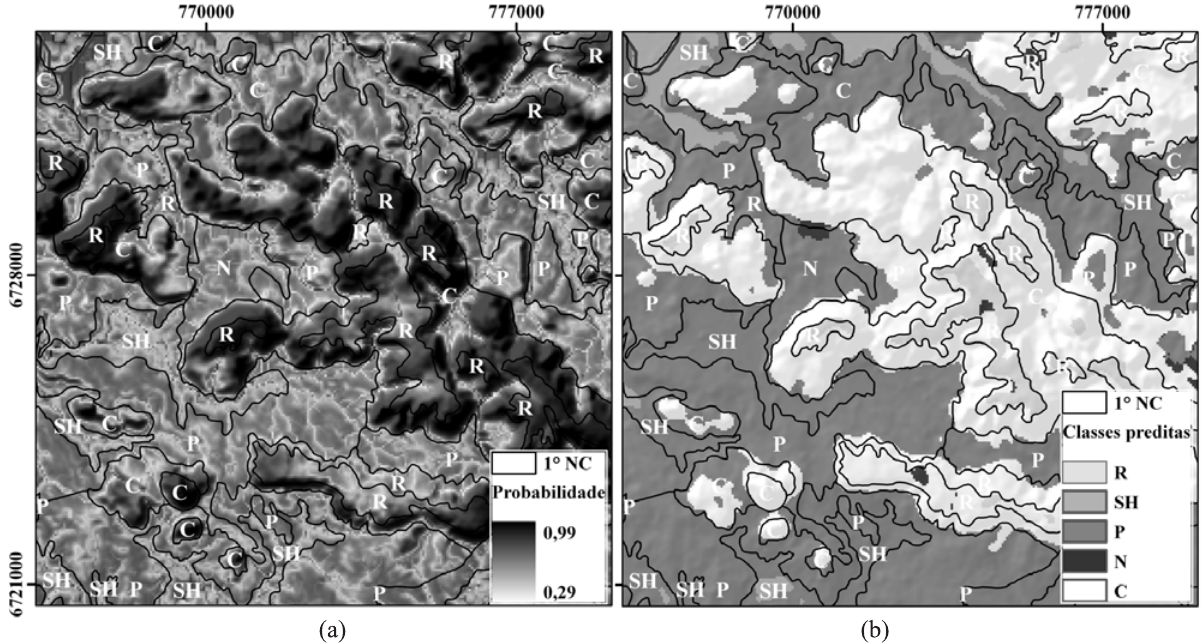
Figura 3. Estrato da área total utilizada no estudo. (a) agrupamento em um único PI dos maiores valores de probabilidade de cada classe de solo. (b) mapa de classes preditas no 1° Nível Categórico (1° NC) na mesma região da imagem esquerda. Sobreposto a essas imagens está o mapa original usado para treinamento. Coordenadas E e N em metros, UTM/SAD69, Fuso 21. Cambissolo (C), Neossolo (R), Solos Hidromórficos (SH), Argissolo (P), Nitossolo (N) e Plintossolo